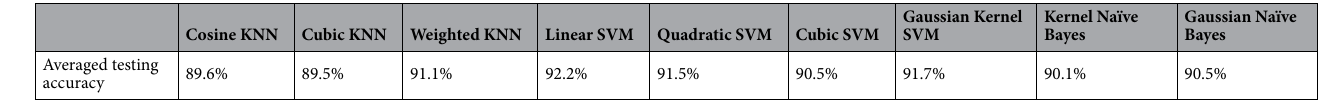
Table 1. Averaged testing accuracy for different